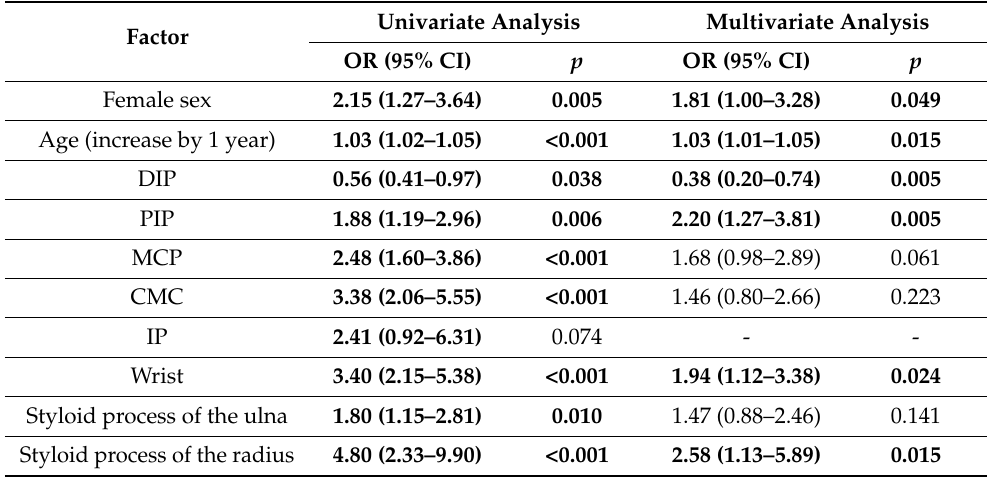
Table 6. Logistic regression for the dependent variable of seropositive RA vs. the independent variable of PsA considering the location of the lesions.